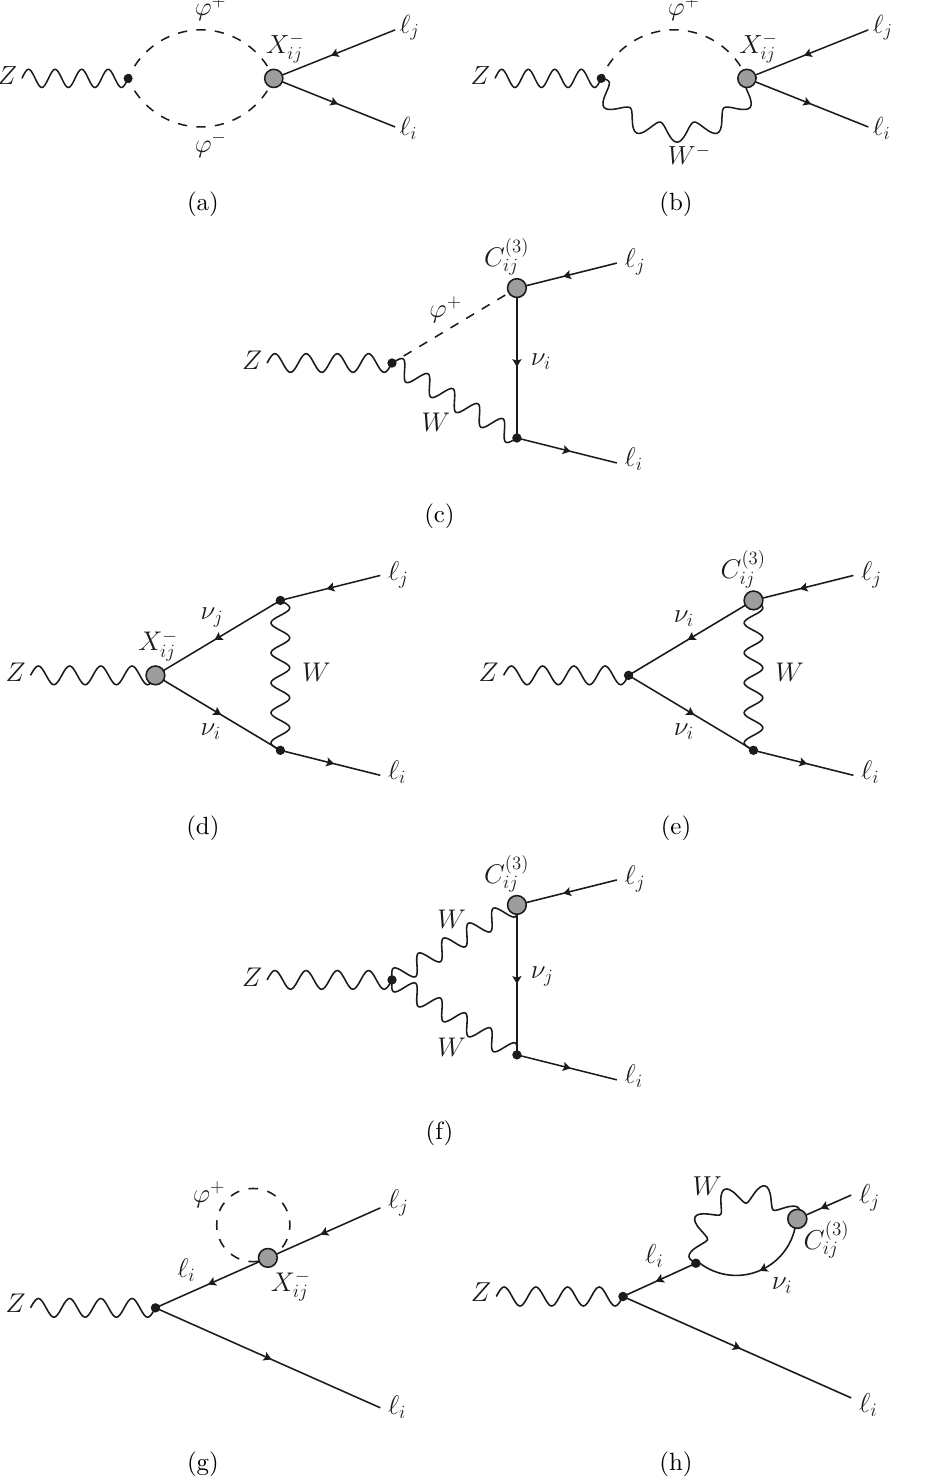
Figure 18. Insertions of X +